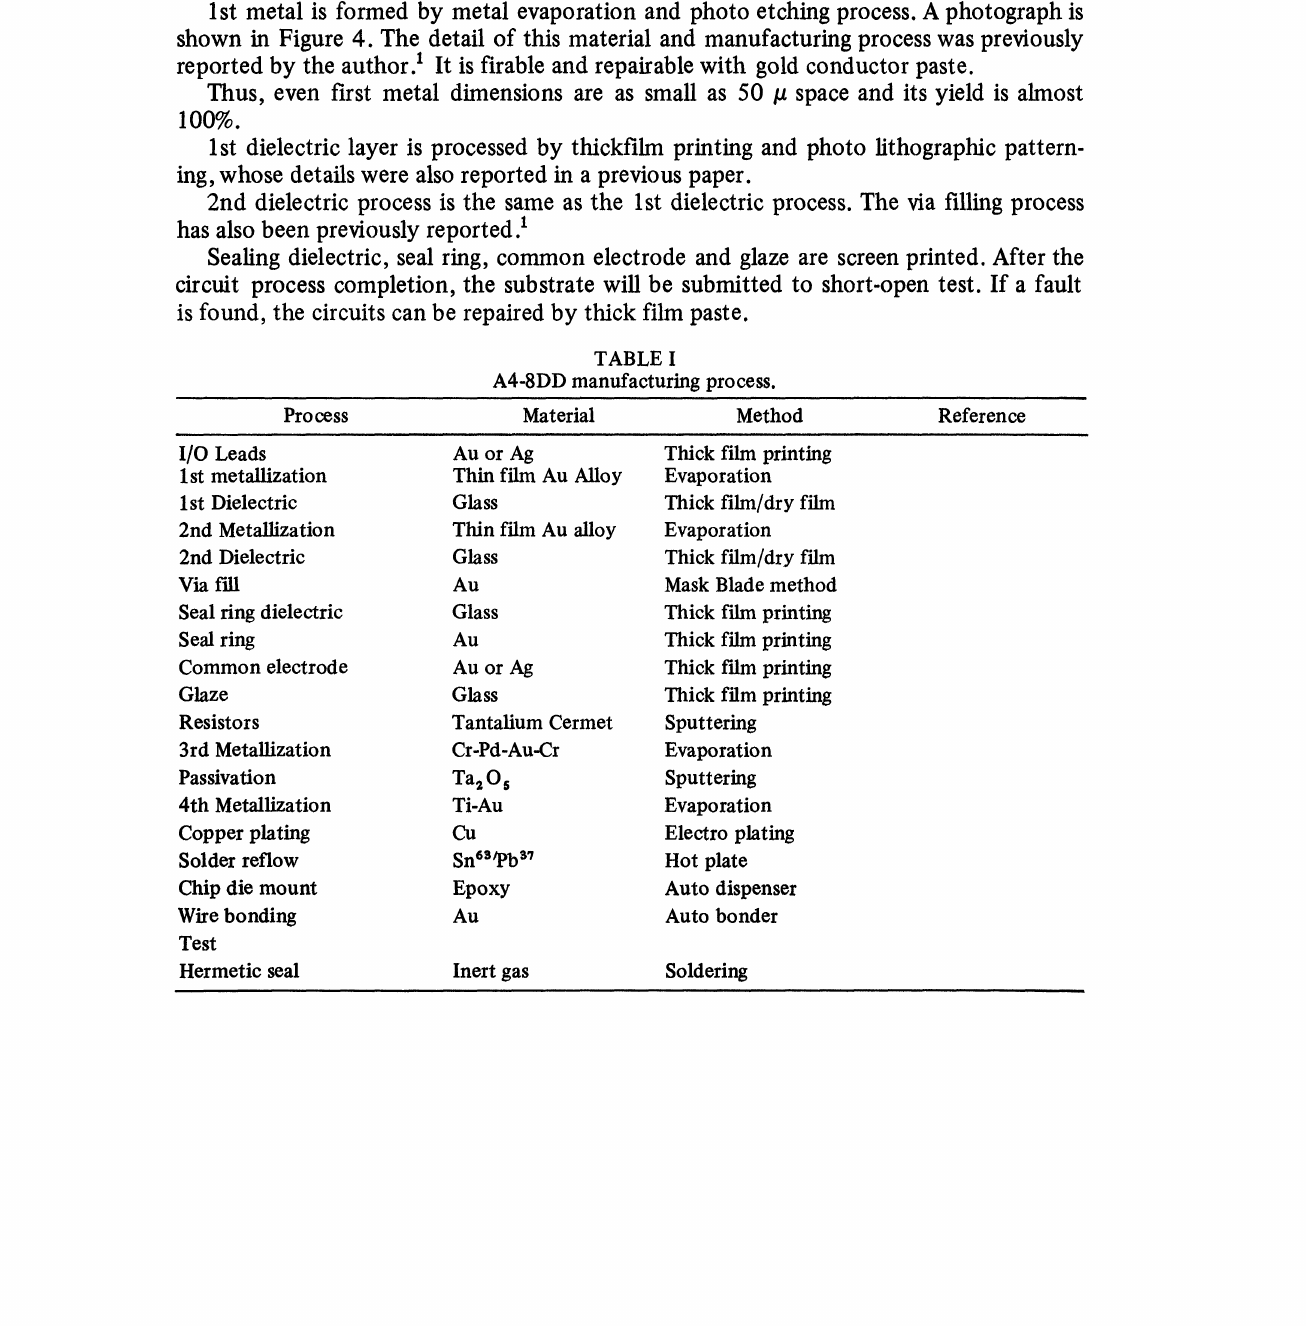
TABLE A4-8DD manufacturing